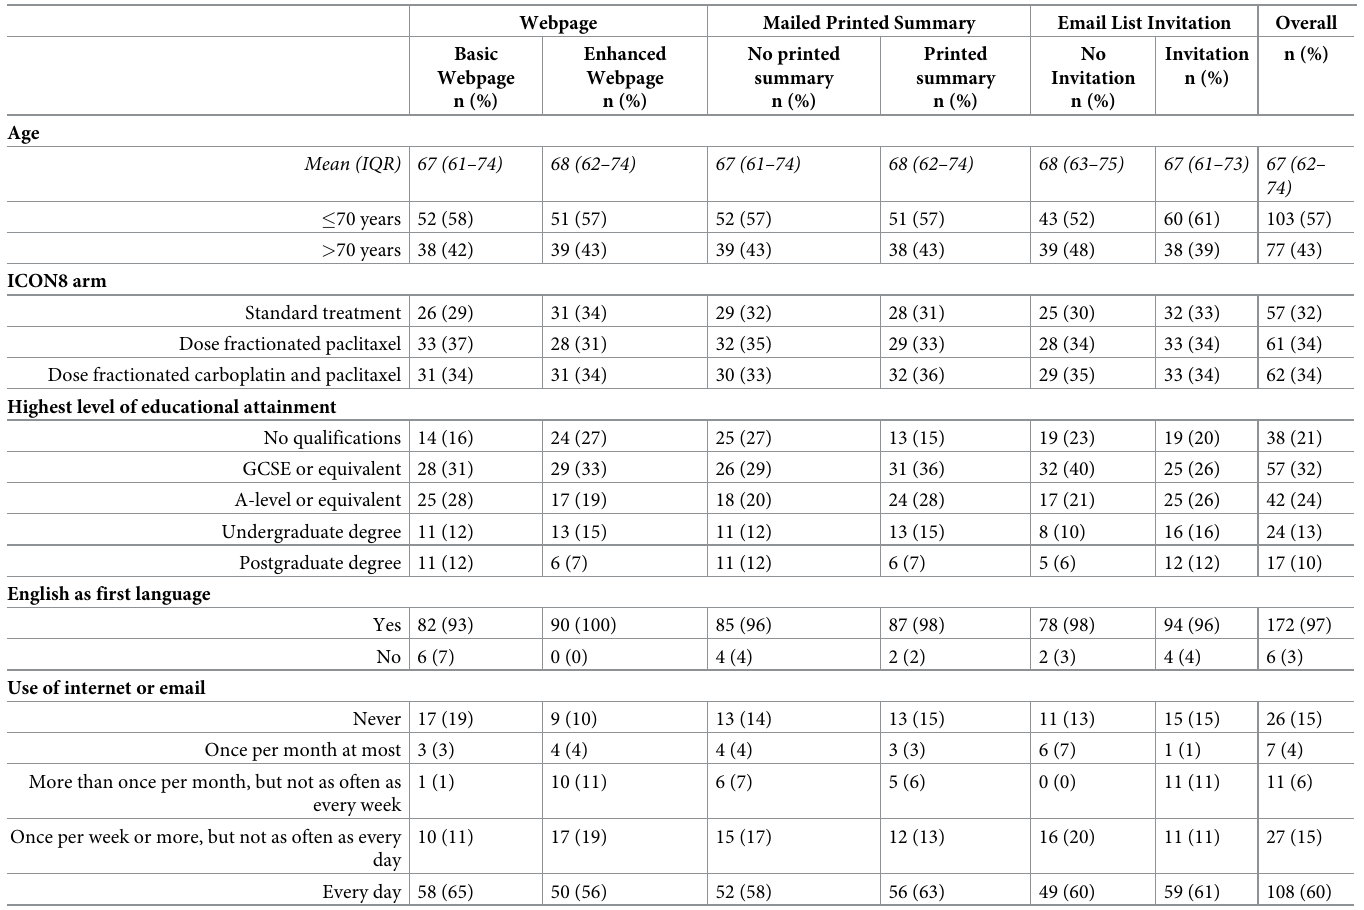
Table 2. Baseline characteristics of participants who returned the